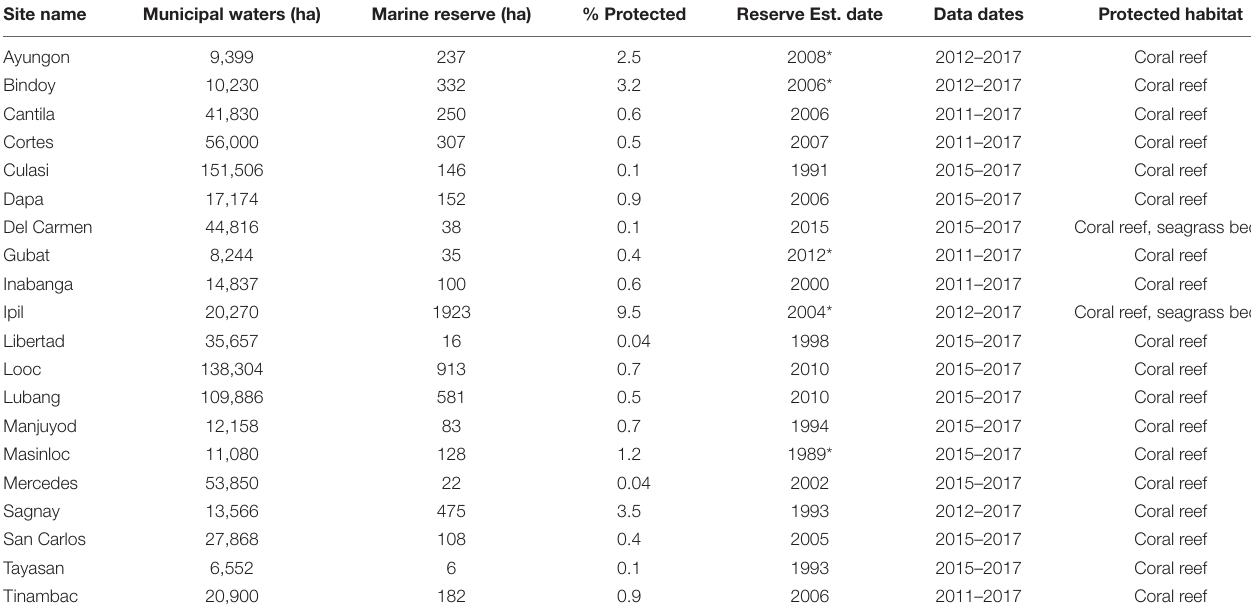
TABLE 1 | Description of marine reserve area, dates of establishment, and range of dates for data collection for each site.